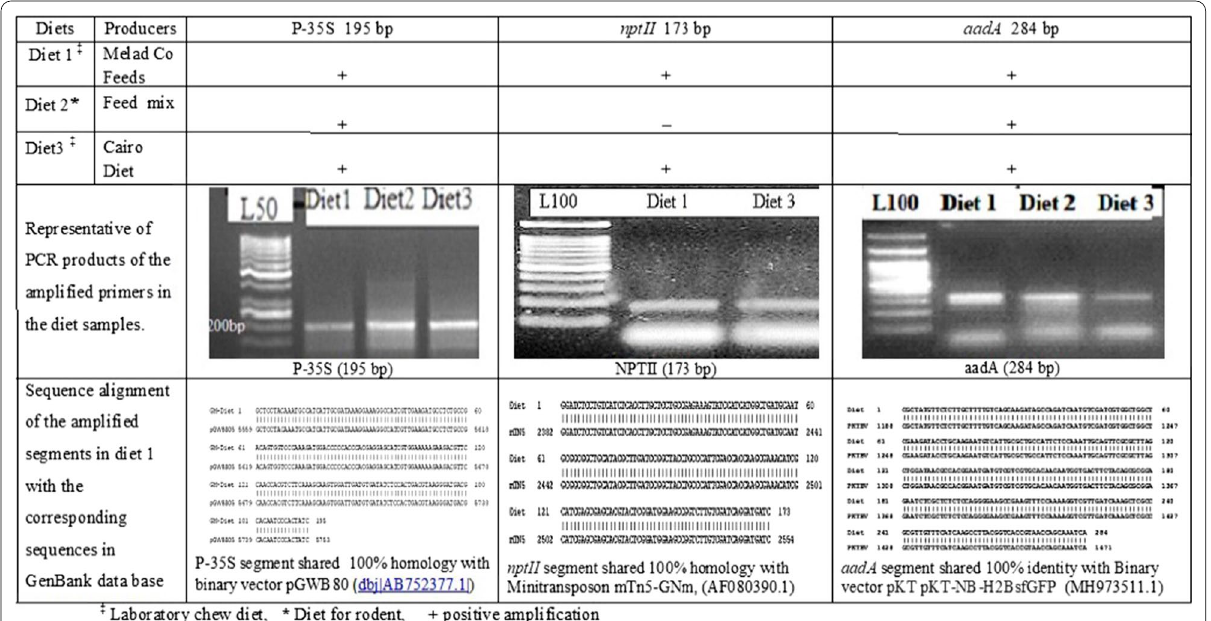
Fig. 1 Detected genetic modifications in the collected diet samples and their nucleotide sequence alignment with